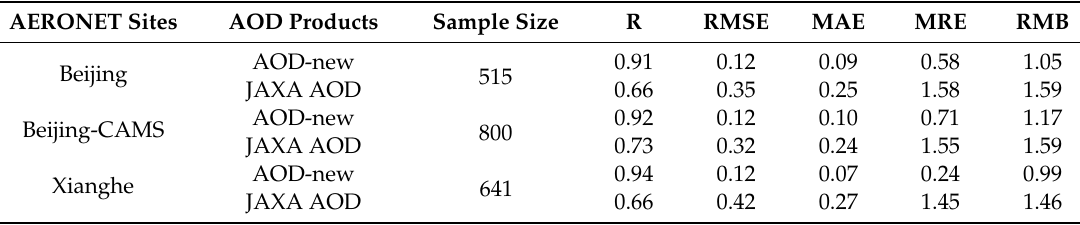
Table 3. Analysis of AHI AOD and ground AOD at di ff erent ground